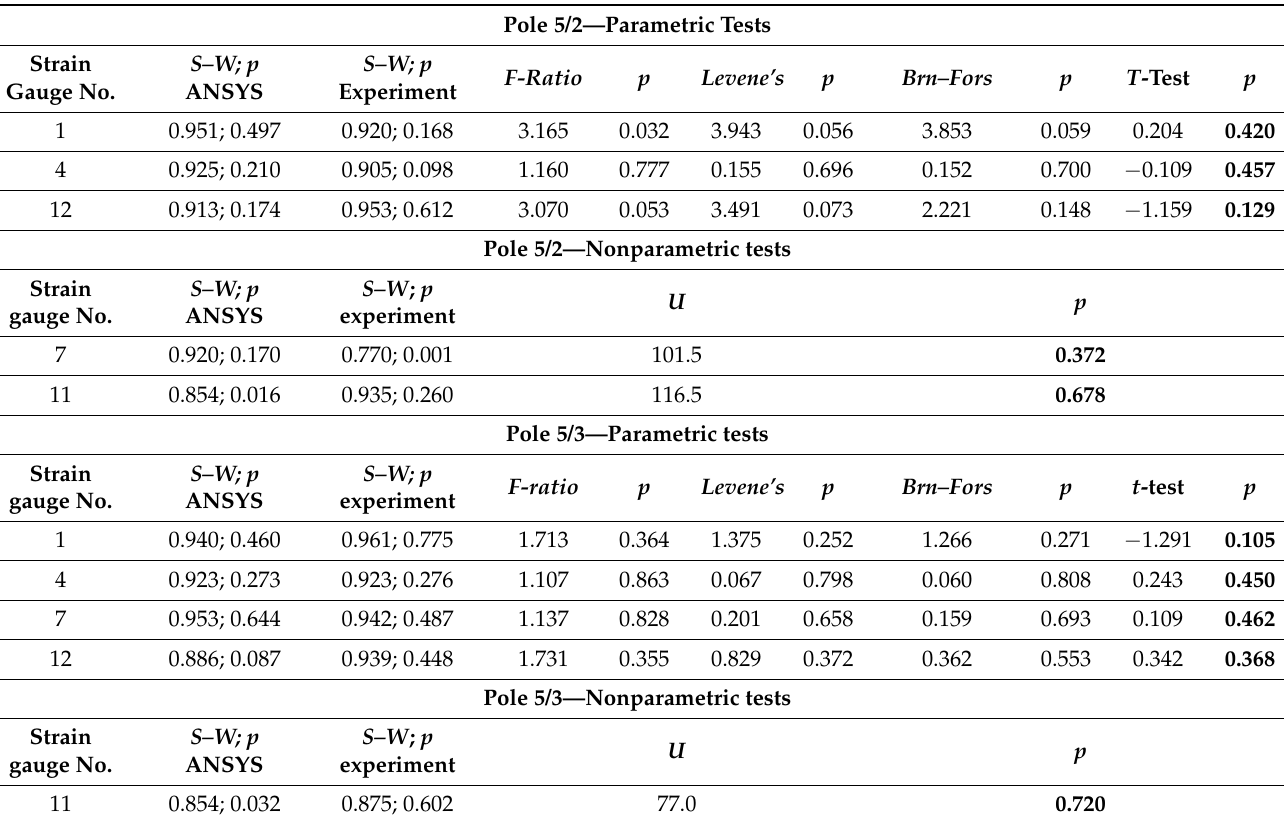
Table 6. Comparison of normal stresses in the vicinity of the inspection opening from numerical simulations carried out in ANSYS software and experimental tests—5 m columns.